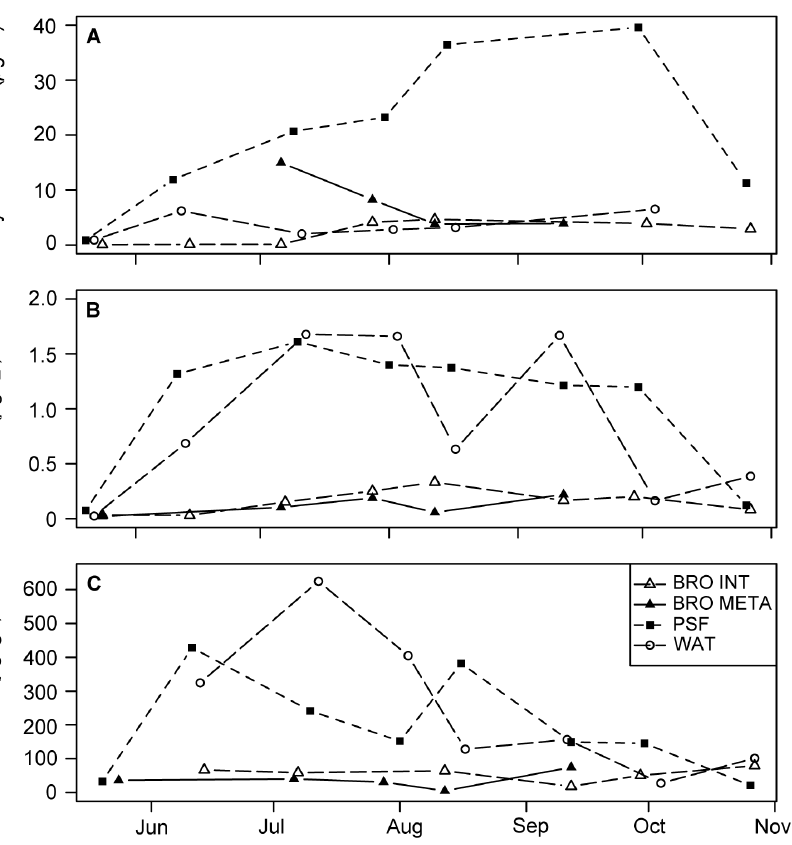
Figure 2. Cyanobacterial biomass and microcystin concentrations from May to October in the three study lakes. A) Cyanobacterial biomass ( m g ? L 2 1 ); and total microcystin concentration expressed as B) m g ? L 2 1 and C) m g ? g 2 1 dry weight.